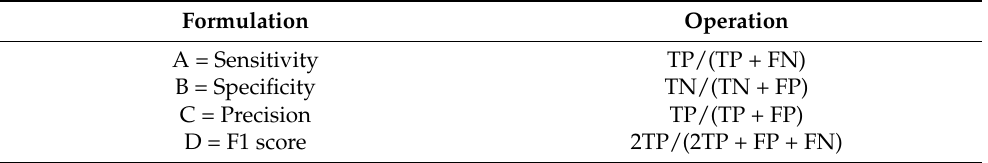
Table 2. Statistical formulations, in which TP = true positive, FP = false positive, TN = true negative and FN = false